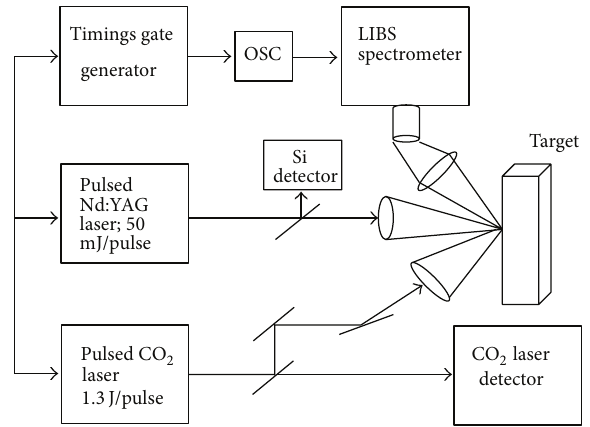
Figure 10: Schematic of the two laser LIBS systems for CO 2 laser enhancement of Nd:YAG induced LIBS plasma emission for the preliminary